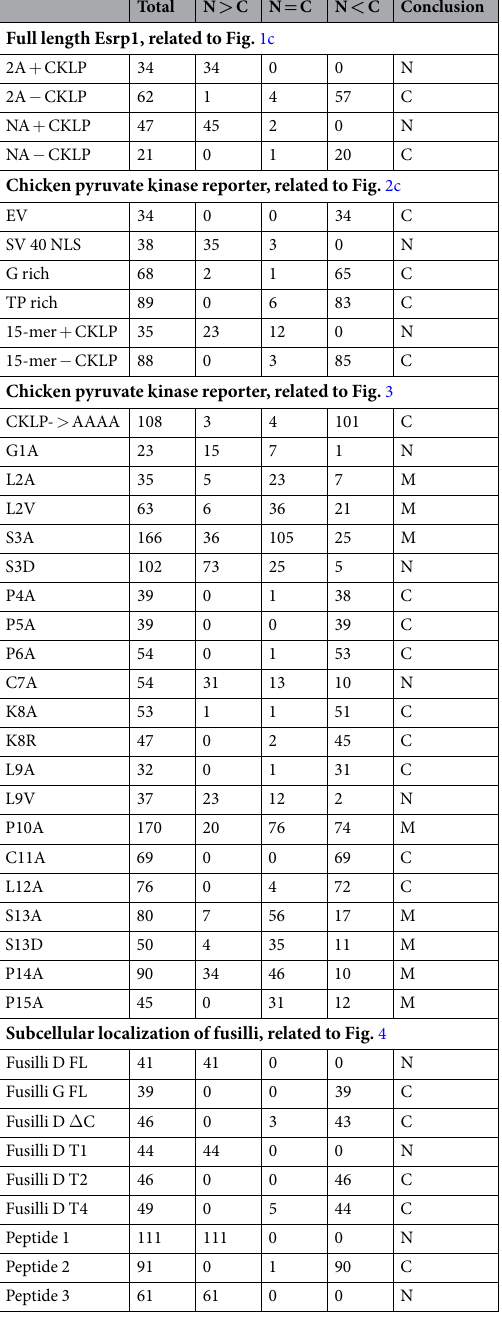
Table 1. Quantification of cells from each transfection on the subcellular localization of target protein. N > C represents predominantly nuclear; N = C represents similar presence in the nucleus and cytoplasm; N < C represents predominantly